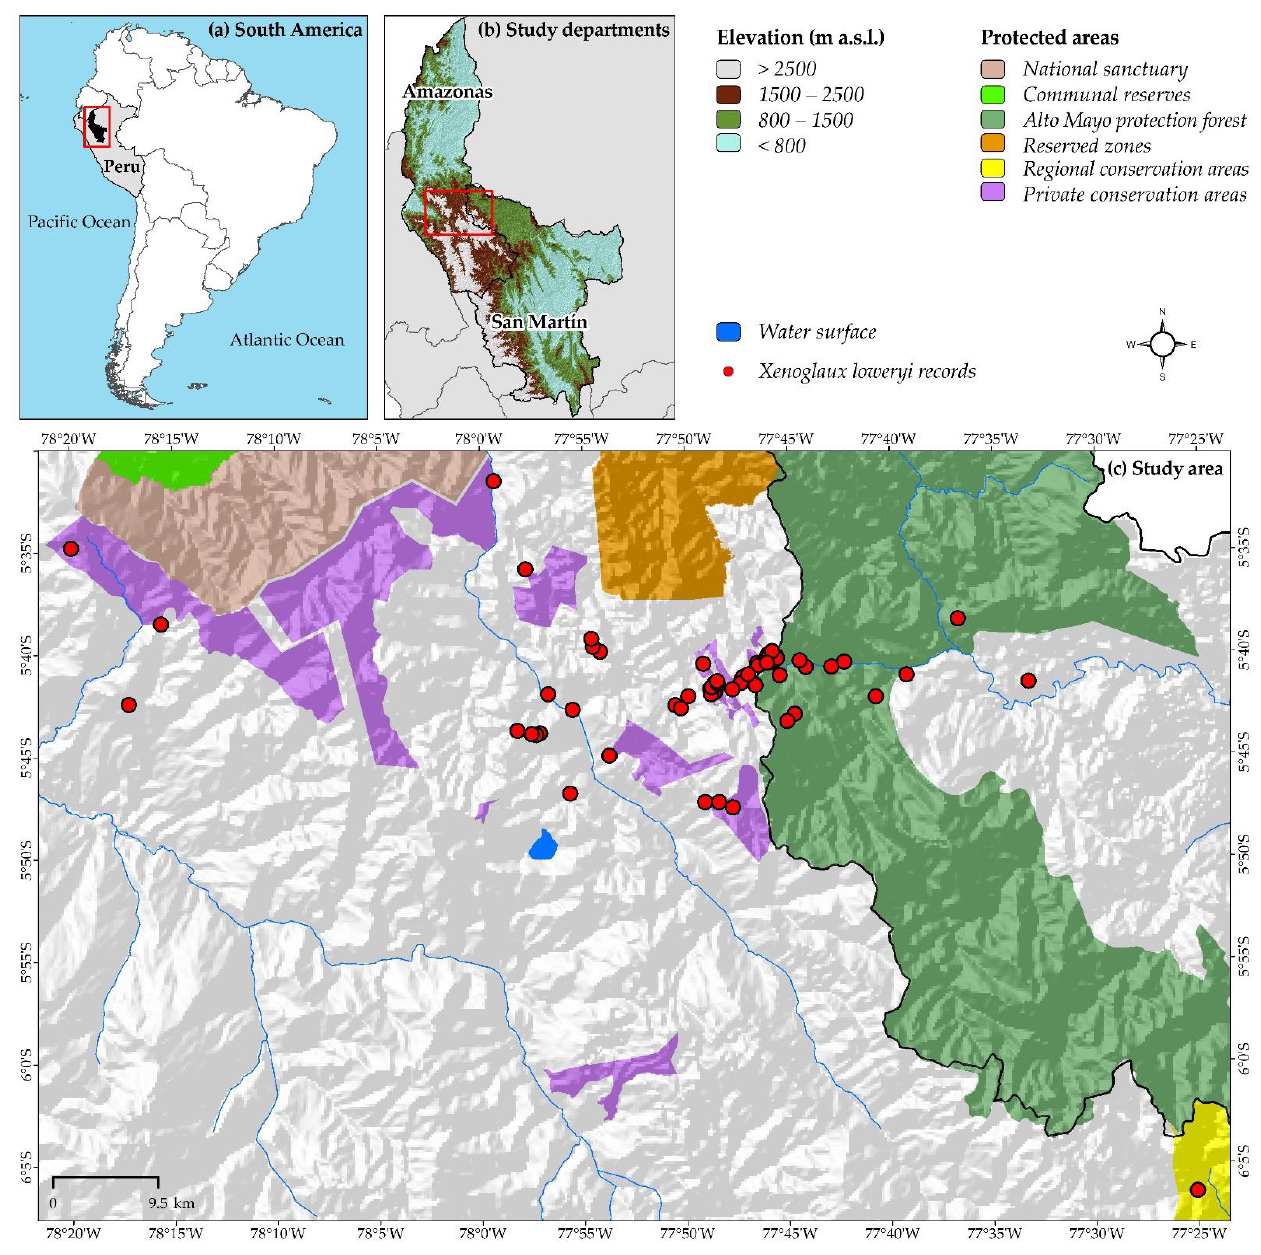
Figure 1. ( a ) South America; ( b ) Study departments; ( c ) Geographic location and protected areas in Amazonas and San Martin (Peru). Natural protected area categories of Amazonas and San Martin: NP: national park, NS: national sanctuary, CR: communal reserve, AMPF: Alto Mayo protected forest, RZ: reserved zones, RCA: regional conservation areas, PCA: private conservation ar- eas.